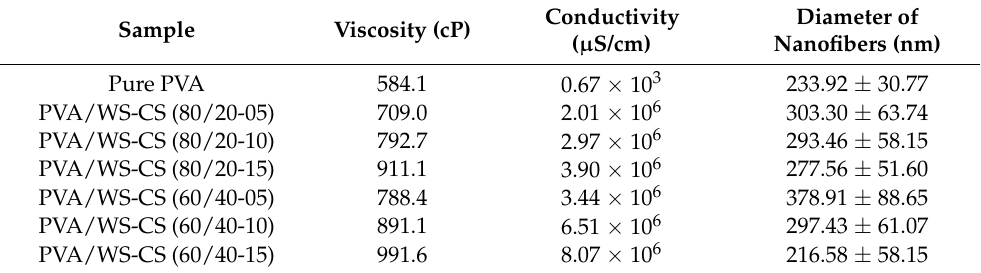
Table 1. Specifications of PVA/WS-CS mixtures and nanofibers.